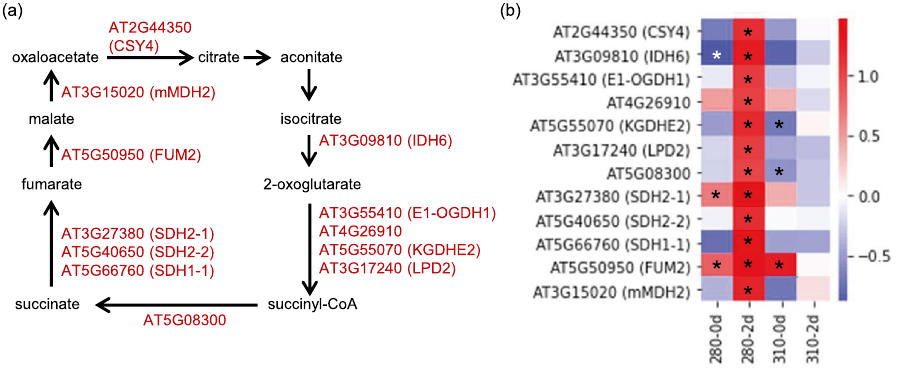
Figure 6. Gene expression profiles of enzymes in TCA cycle under 280 and 310 nm UV-LEDs. ( a ) Metabolic map of TCA cycle. ( b ) Heat map showing the expression level of enzymatic genes in TCA cycle. Changes in gene expression levels relative to the control are expressed as log 2 (fold change) values. As shown on the color scale, blue indicates down-regulation and red indicates up-regulation. Asterisks indicate significant differences between the control and UV-LED irradiation using Welch’s t -test ( P <